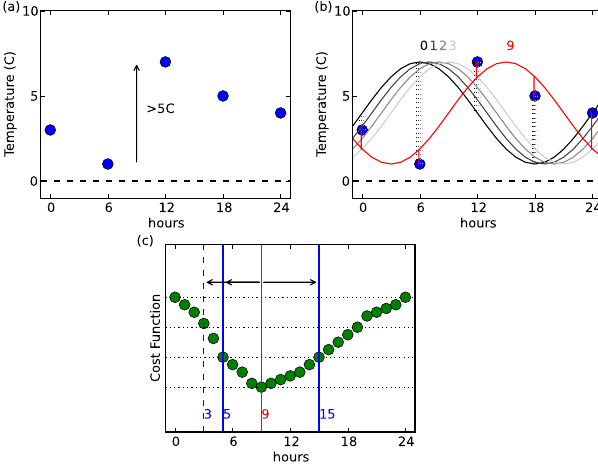
Fig. 5. Schematic for the diurnal cycle check. (a) An example time series for a given day. There are observations in more than 3 quar- tiles of the day and the diurnal range is more than 5 ◦ C so the test will run. (b) A sine curve is fitted to the day observations. In this schematic case, the best fit that occurs has a 9-h shift. The cost func- tion used to calculate the best fit is indicated by the dotted vertical lines. (c) The cost function distribution for each of the possible 24 offsets of the sine curve for this day. The terciles of the distribution are shown by horizontal black dotted lines. Where the cost func- tion values enter the second tercile determines the uncertainty (ver- tical blue lines). The larger of the two differences (in this case 9 to 15=6h) is chosen as the uncertainty. So if the climatological value is between 3 and 15h, then this day does not have an anomalous diurnal cycle